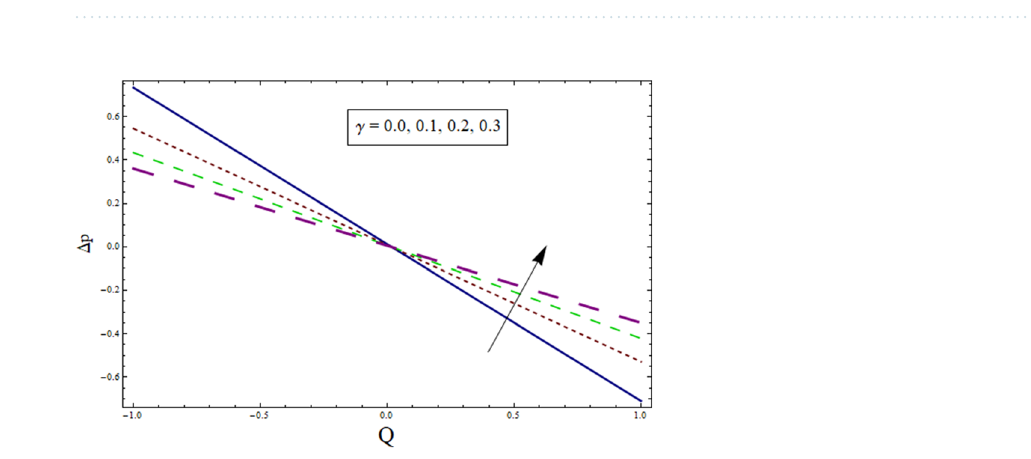
Figure 20. Δp for H .